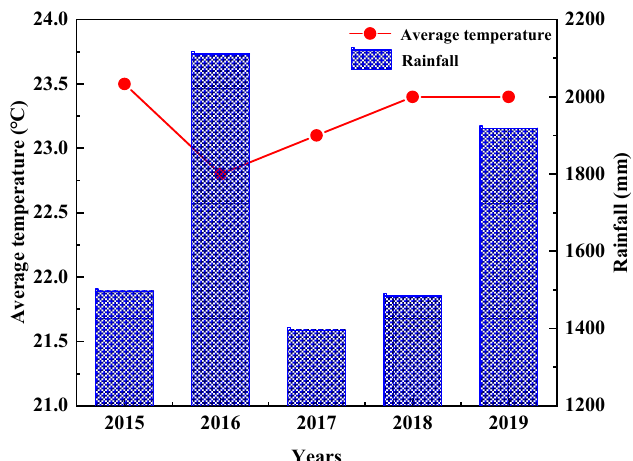
Figure 23. Shantou climate characteristics in five recent years.(Adapted from Ref. [3]).